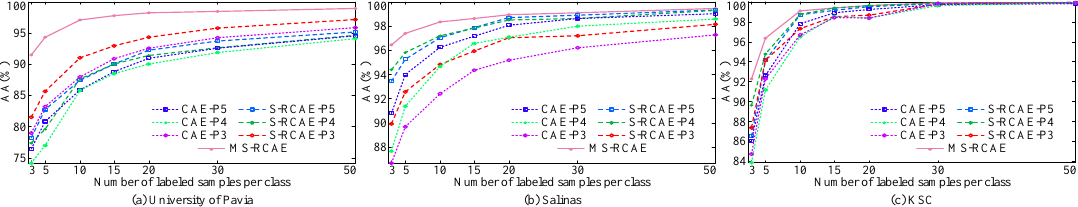
Figure 8. Comparison of classification results from spectral–spatial feature learned by CAE, S-RCAE, and multiscale feature by MS-RCAE on datasets of ( a ) University of Pavia, ( b ) Salinas, and ( c )